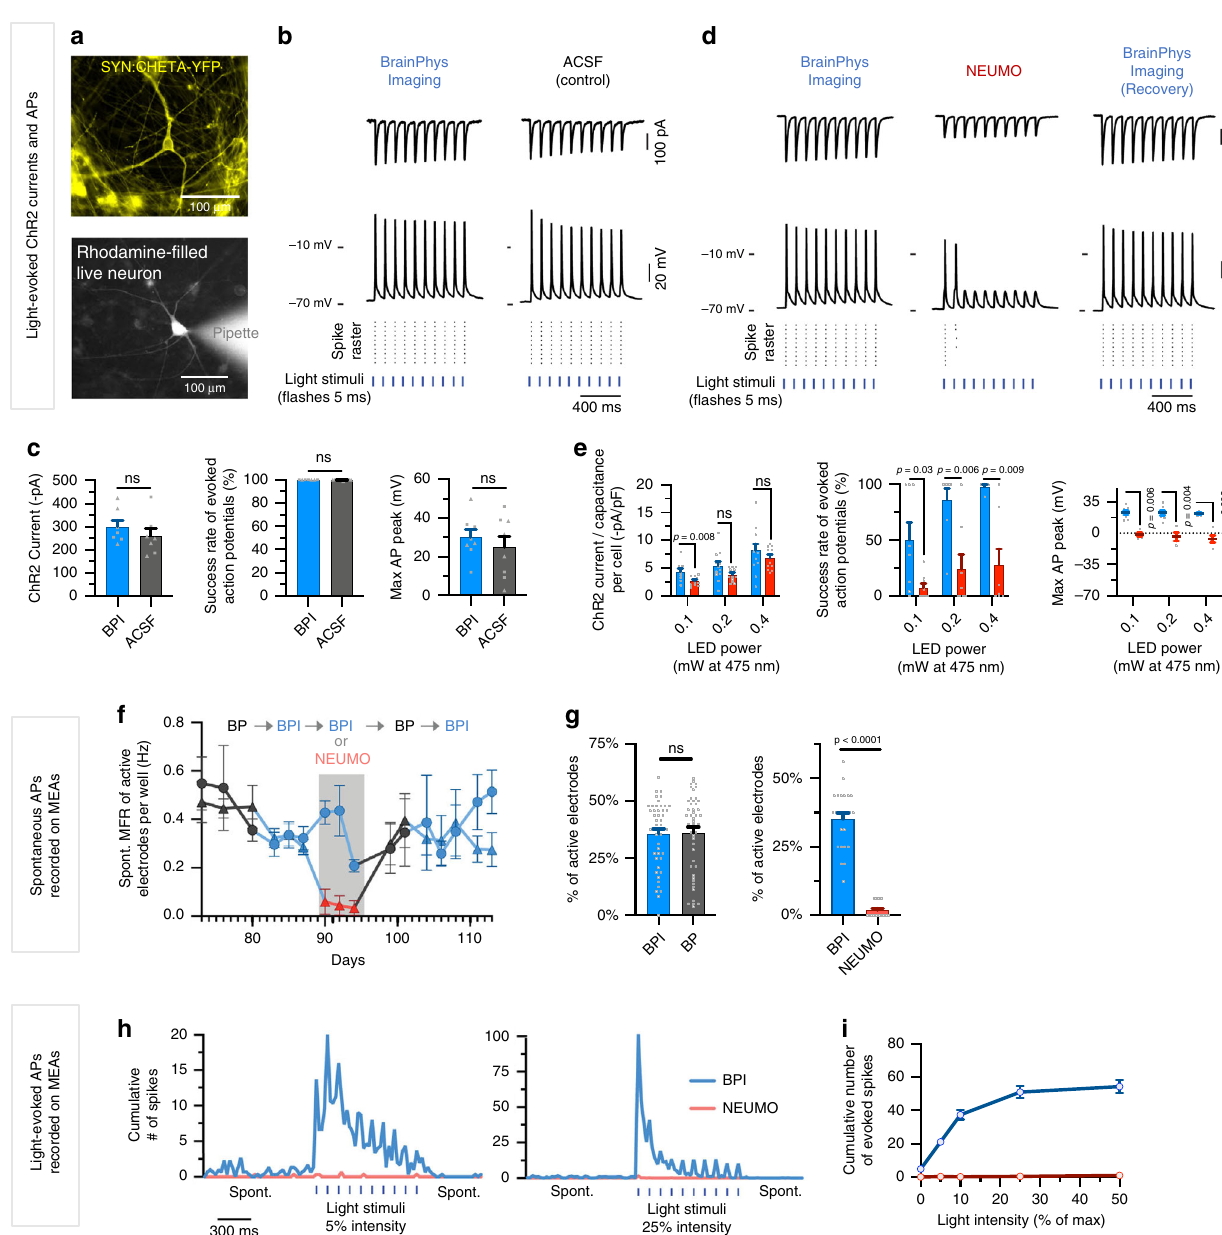
Fig. 7 BPI supports the optogenetic control of human neurons in vitro. a – e Optogenetics of human neurons with whole-cell patch-clamp recordings in BrainPhys Imaging (BPI), arti fi cial cerebrospinal fl uid (ACSF), and NEUMO. Each data point in the histograms represents a neuron. a Example images of neurons expressing synapsin:ChETA-YFP optogene and fi lled with rhodamine from the patch-pipette. b Whole-cell patch-clamp traces of neurons stimulated with 10 × 5 ms fl ashes of 0.4 mW blue light at 10 Hz in BPI or ACSF. Bottom of the graph shows corresponding spike raster plots. c Neurons patched in ACSF or BPI and stimulated with identical light parameters in b show no signi fi cant difference across ChR2 currents (BPI, ACSF; n = 7), action potential (AP) success rates (BPI, n = 7; ACSF, n = 8) and max AP amplitudes (BPI, ACSF; n = 8). Symbols represent neurons tested fi rst (triangles) or second (circles) in either medium. d Optogenetic responses from the same patch-clamped neuron under 0.1 mW of blue light in BPI, NEUMO, and BPI (recovery) show optimal optogenetic control in BPI. e Quanti fi cation of patched neurons ( n = 22 across four coverslips) recorded in BPI or NEUMO, stimulated with 10 × 5 ms fl ashes of blue light at 10 Hz with increasing power. f – i Optogenetically evoked and spontaneous fi ring rates of human neurons expressing synapsin:ChETA-YFP recorded in BP, BPI or NEUMO (with identical supplements) using multielectrode arrays (MEAs). Neurons were cultured in standard BP for 82 days before transitioning to “ test ” media. f , g Recordings were split into two groups: “ circles ’” (8 wells) and “ triangles ” (7 wells). Both groups were changed to BPI at day 82; only “ triangles ” switched to NEUMO at days 89 – 95. From day 96, both groups were cultured in BP for one week before switching to BPI. h , i Optogenetic responses of human neurons on MEAs in NEUMO ( n = 112 electrodes) or BPI ( n = 128 electrodes) when stimulated with blue light (Lumos) at increasing intensities. The cumulative number of spikes was summed in binning windows; h 27.5ms bins; i 2 s bins from fi rst light stimulus over three sweeps. Data in h were plotted with quadratic non-linear curves. Values in c , e , g , i are presented as mean ± SEM. Signi fi cance determined via two-tailed nonparametric unpaired (Mann – Whitney) tests. ns, P >